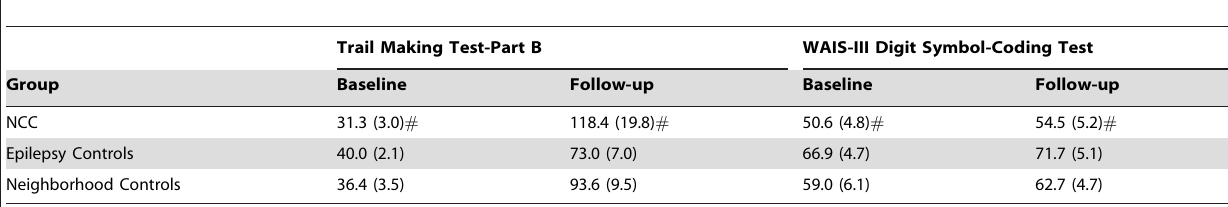
Table 5. Individual cognitive test scores within the processing speed composite at baseline and 6-month